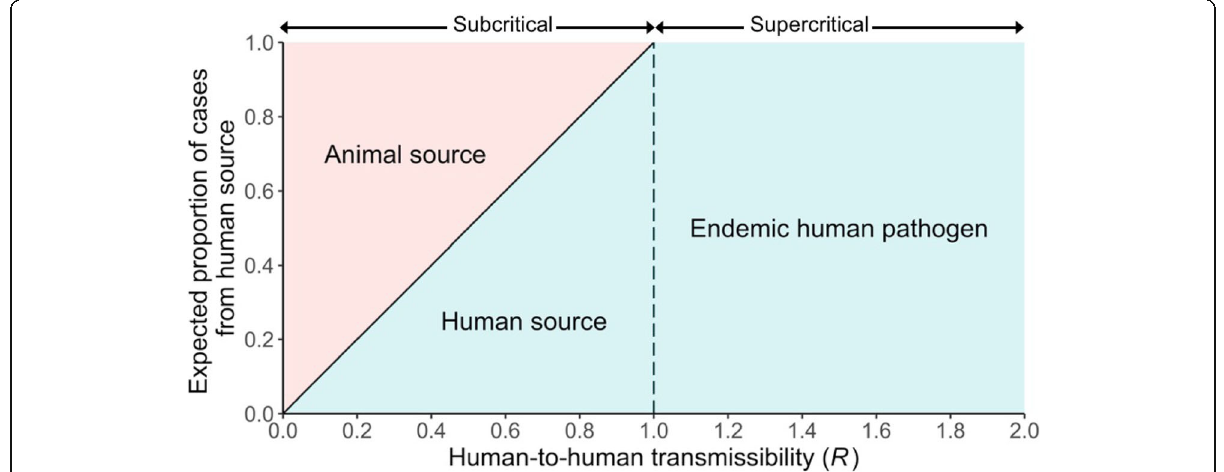
Fig. 1 The expected source of infection for cases is determined by the reproductive number for human-to-human